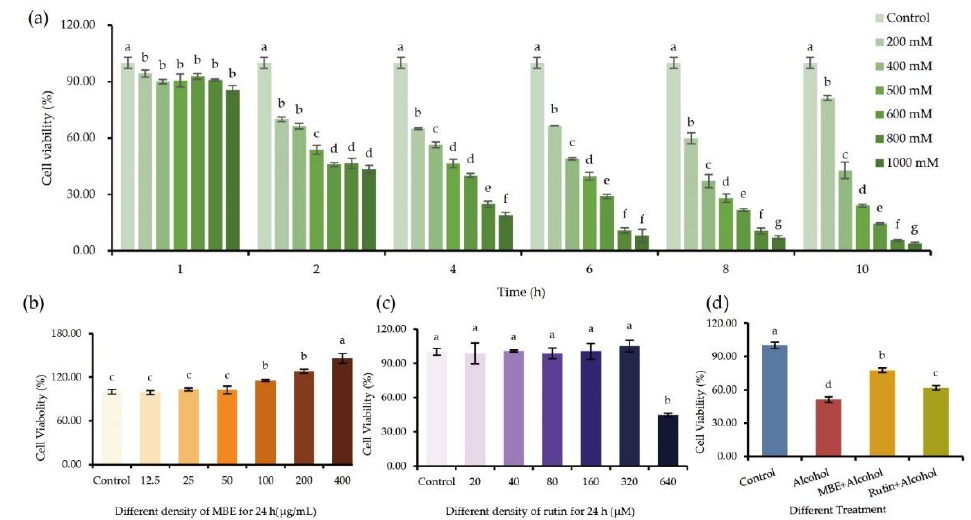
Figure 2. MBE and rutin can reduce the alcohol damage to GES-1. The cell viability was determined using MTT assay: ( a ) effect of different concentrations alcohol on GES-1 cells viability; ( b ) effect of MBE on GES-1 cell viability; ( c ) effect of rutin on GES-1 cell viability; ( d ) effect of MBE&rutin on alcohol injured-GES-1 cells viability; GES- 1 cells were pretreated with 400 μg/mL MBE and 320 μM rutin for 24 h, then treat with 500 mM alcohol for 4 h. Different letters indicating significant differ- ences labeled at the inhibitory activity at different compounds ( p < 0.05).